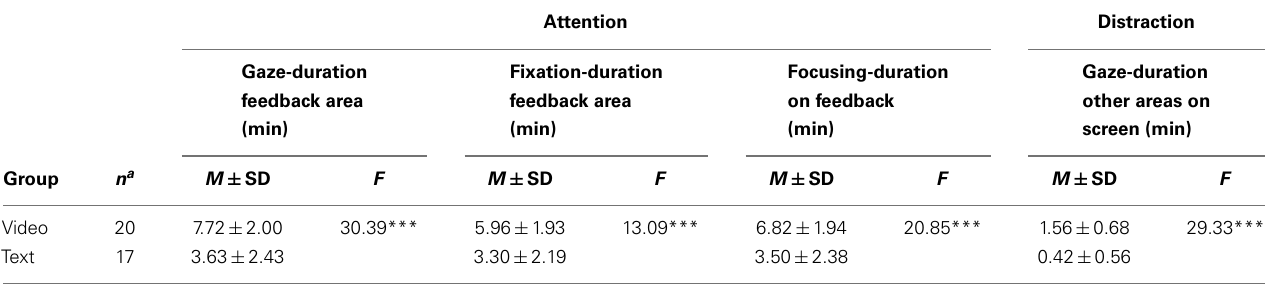
Table 2 | Descriptive statistics for gaze-, fixation-, and focusing-duration in the feedback area and distraction by group (video and text) .